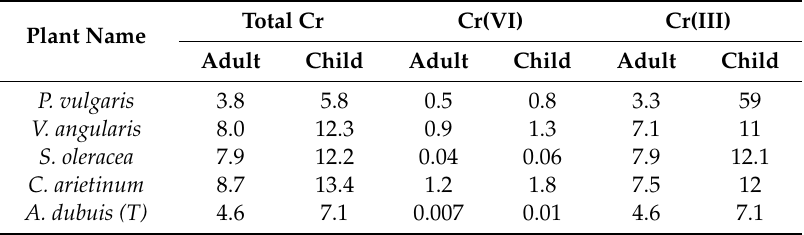
Table 5. Hazard quotients (HQ) of Ch T , Cr(VI) and Cr(III) to consumers of vegetables grown on soil spiked with